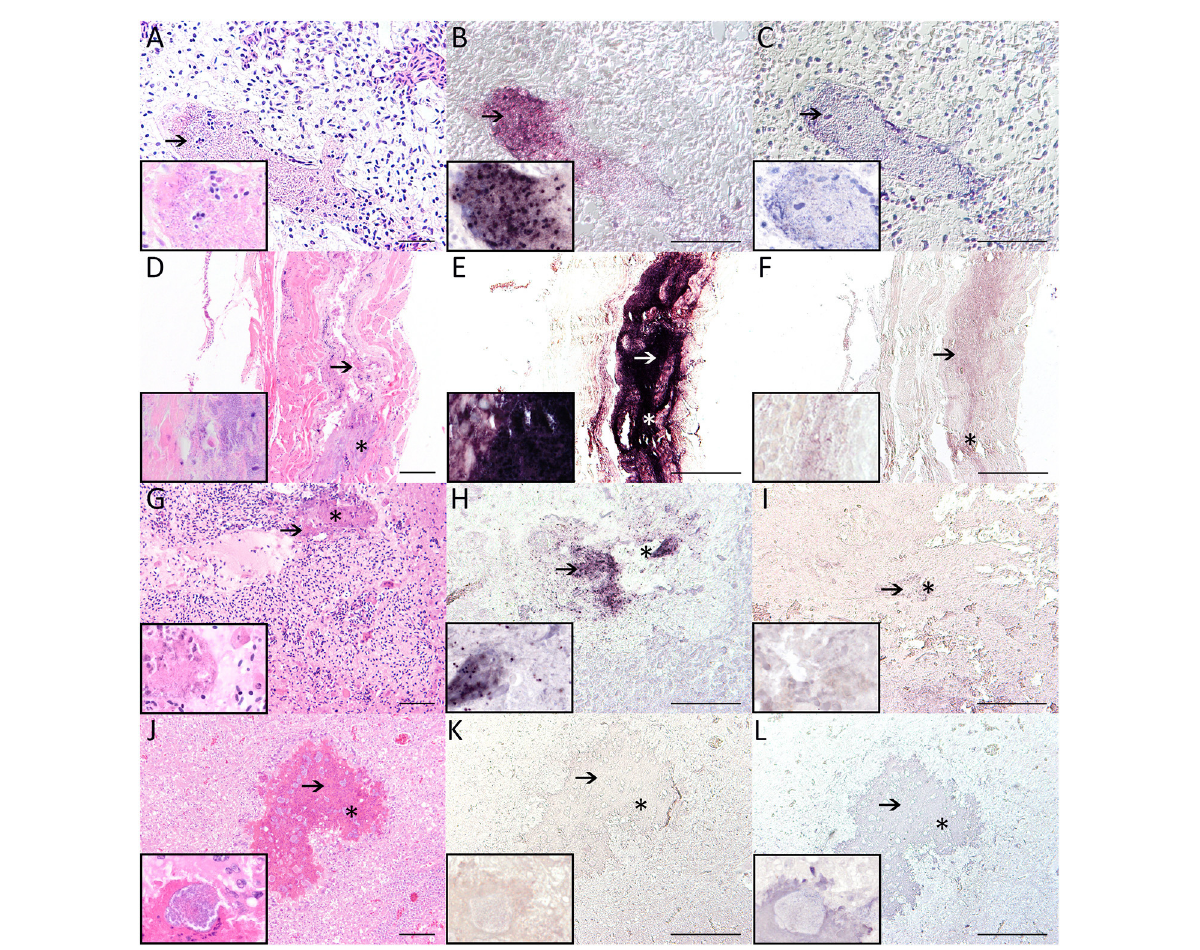
FIGURE2 Pictures show hematoxylin and eosin stain (A,D,G,J) , in situ hybridization using the anti- Suttonella in situ probe (B,E,H,K) and results after incubation with hybridization buffer only (C,F,I,L) . Pulmonary vessel (case 3) with intraluminal bacteria [arrow; (A–C) ] as well as observed tracheal [case 4; (D–F) ] and hepatic lesions [case 5; (G–I) ], which are characterized by loss of organotypical architecture, accumulation of debris (arrows) and presence of bacterial structures (asterisks), show a strong positive reaction (purple precipitate; arrows) in in situ